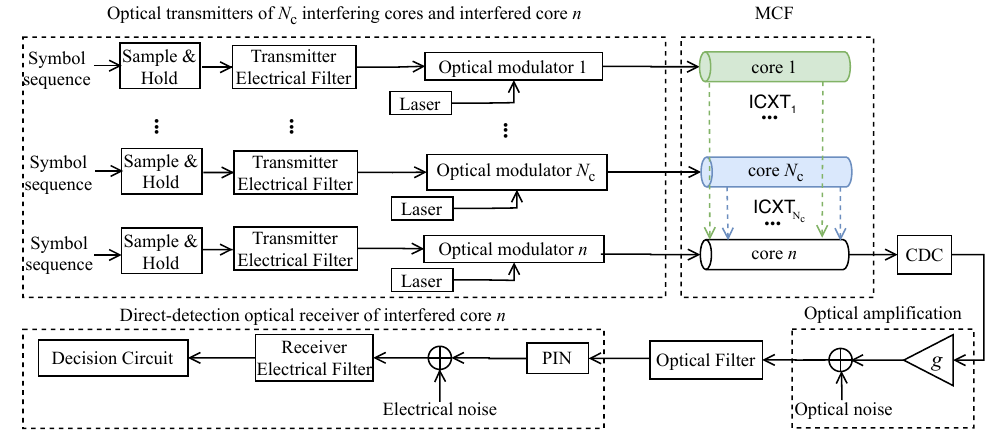
Figure 1. System equivalent model of an optically amplified inter-DCI link supported by a MCF and with